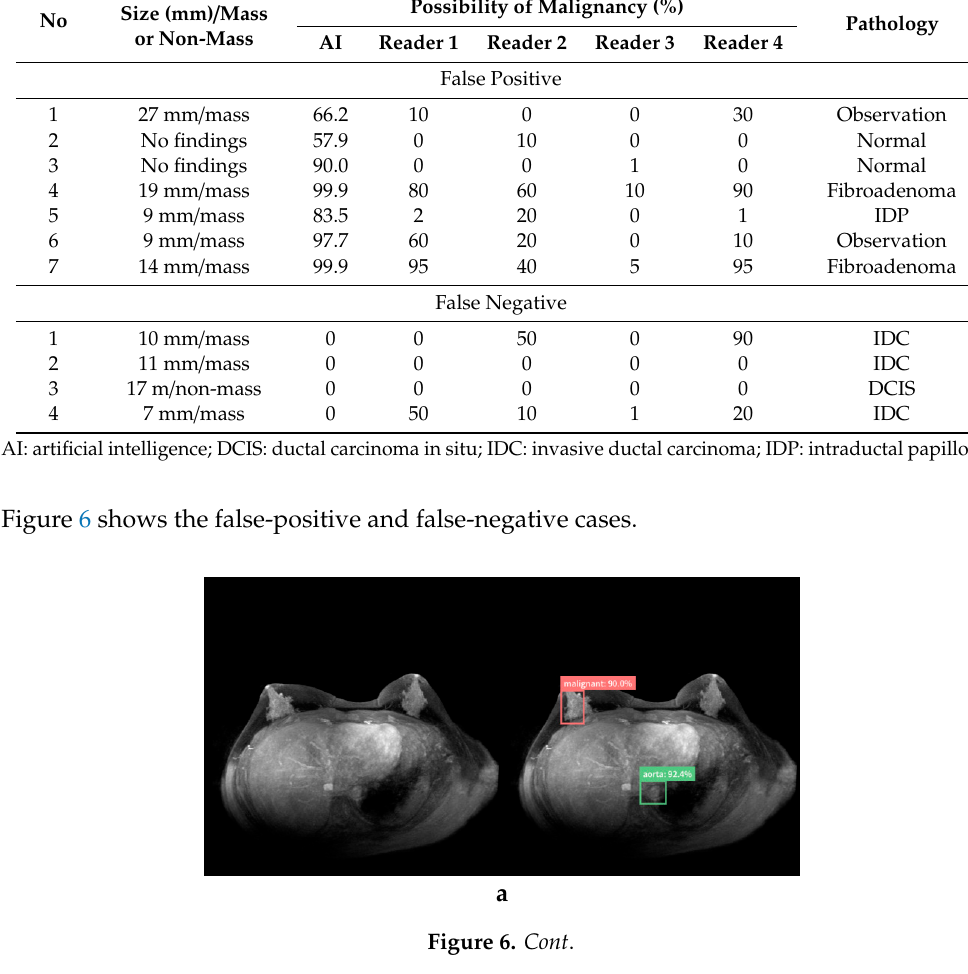
Table 5. Pathological features of false-positive and false-negative cases diagnosed by AI.